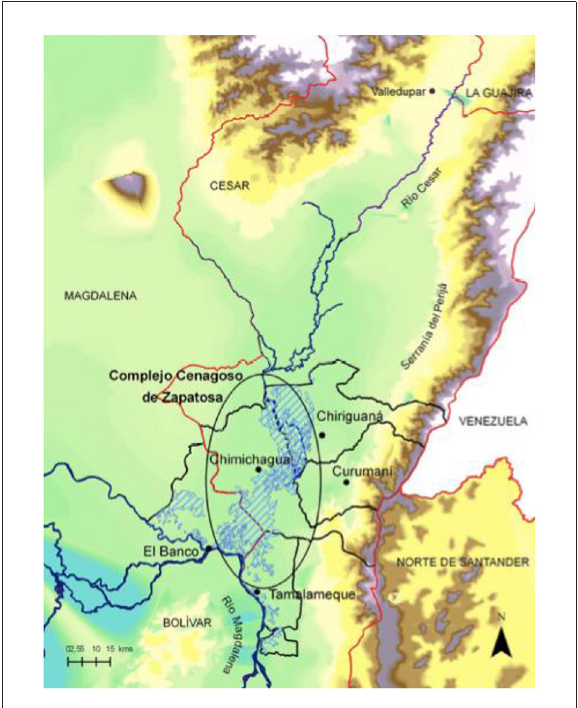
FIGURE6 Marshes of Zapatosa, César (Colombia). Source: IGAC (2018).